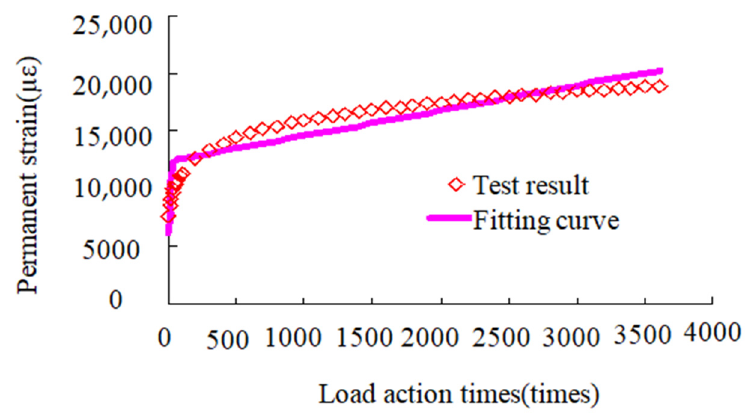
Figure 6. Dynamic creep test results of asphalt mixture.